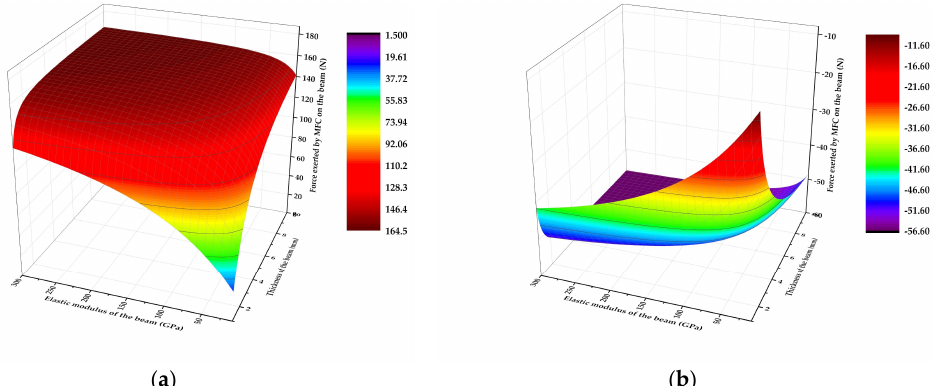
Figure 5. The relationship between the total actuating force of the MFC, thickness, and the structural elasticity modulus, in ( a ) the M2814-P1 type; ( b ) the M2814-P2 type.